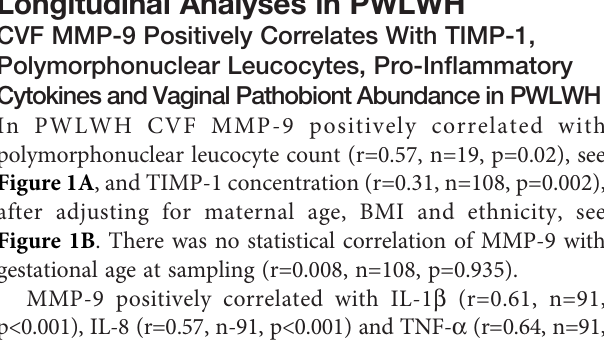
Figure 3A . Mean abundance of adverse anaerobic pathobionts correlated positively with TIMP-1 (p<0.02): Gardnerella (r=0.51, n=77, p<0.001), Atopobium (r=0.56, n=77, p<0.001) and